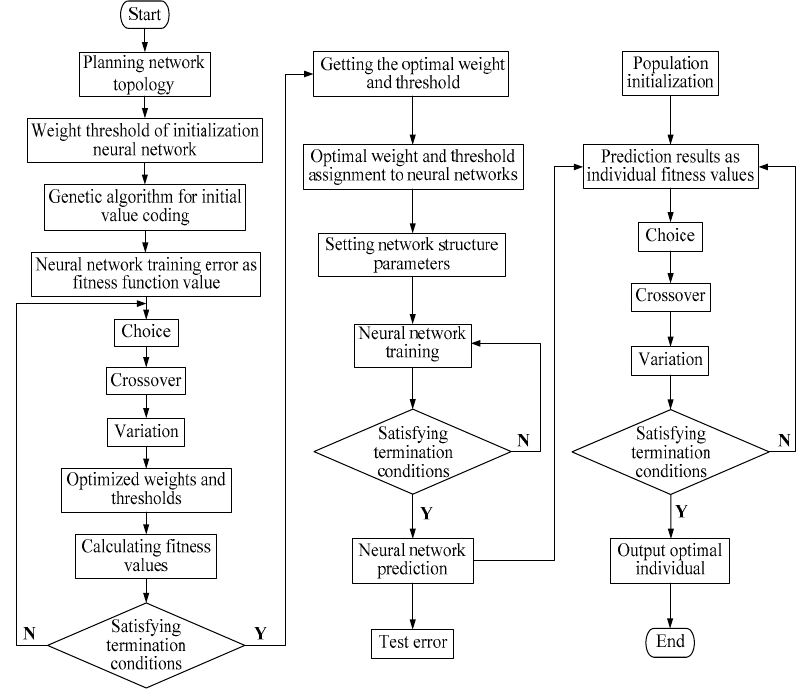
Figure 4. Overall algorithm flow.